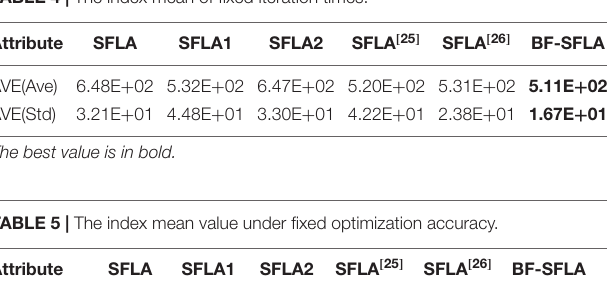
TABLE 4 | The index mean of fixed iteration times.